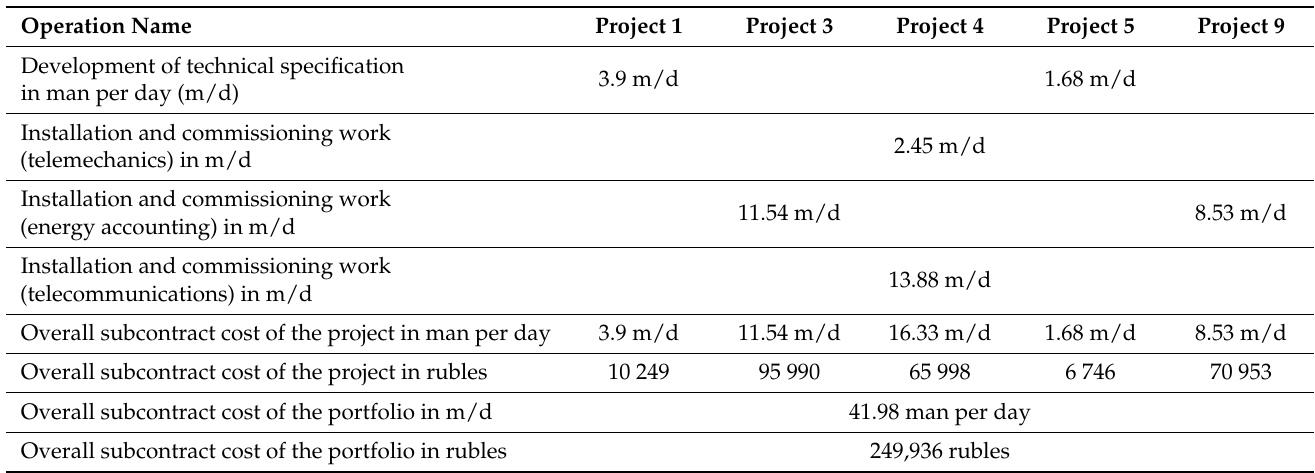
Table 6. Subcontracted resources’ cost allocation for the initial schedule.